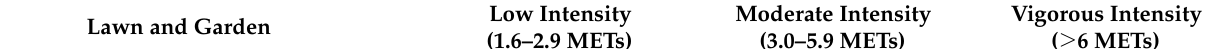
Table 1. Classification of the intensity of various gardening activities. Adapted from